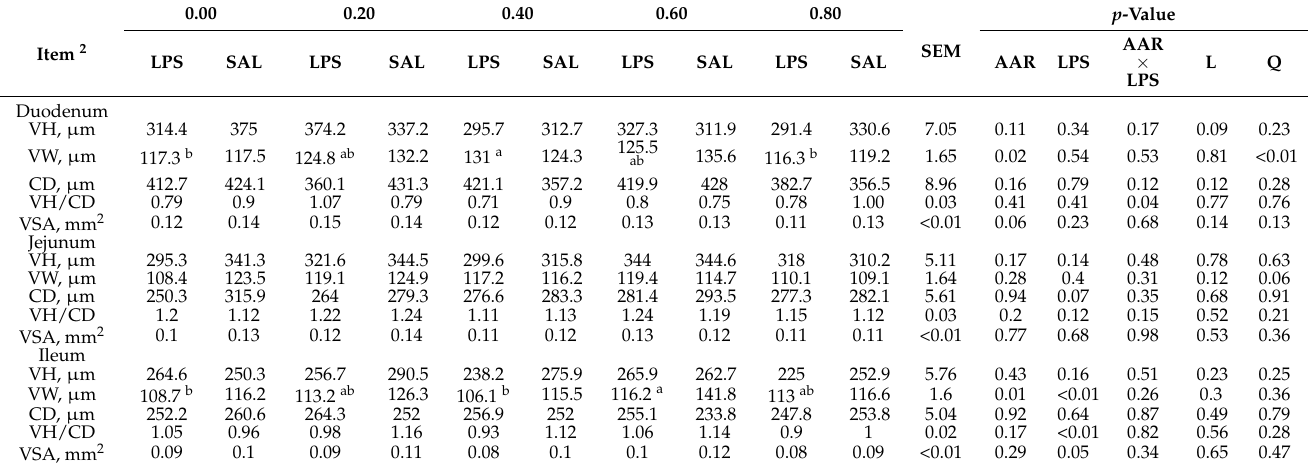
Table 3. Influence of diet with different amylose–amylopectin ratio and LPS challenge (intraperitoneal injection) on the intestinal morphology of weaned piglets 1